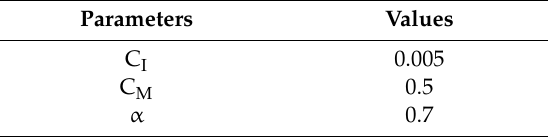
Table 2. The parameters for iARD–RPR model in injection molding simulation.